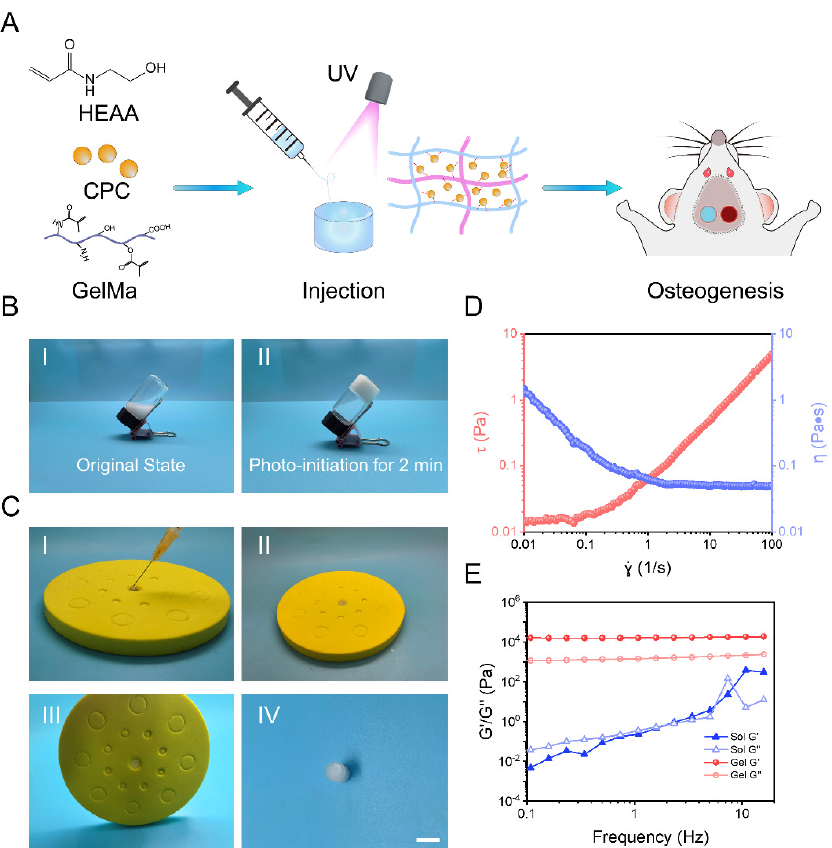
Figure 1. Schematic representations of GelMA-PHEAA/CPC hydrogels for bone regeneration ( A ). The optical images present the sol−gel transformation of hydrogels, and I–II represent the original state and after photo-initiation of GelMA-PHEAA/CPC precursor and GelMA-PHEAA/CPC hydro- gel, respectively ( B ). The optical images present the injectability and ability to form in situ of the materials, and I–IV represent precursor injection, defect filling, formation in situ, and final shape, respectively ( C ). Rheological behavior of pre-solution and hydrogels under rotation ramp mode ( D ) and dynamic frequency sweep tests ( E ).